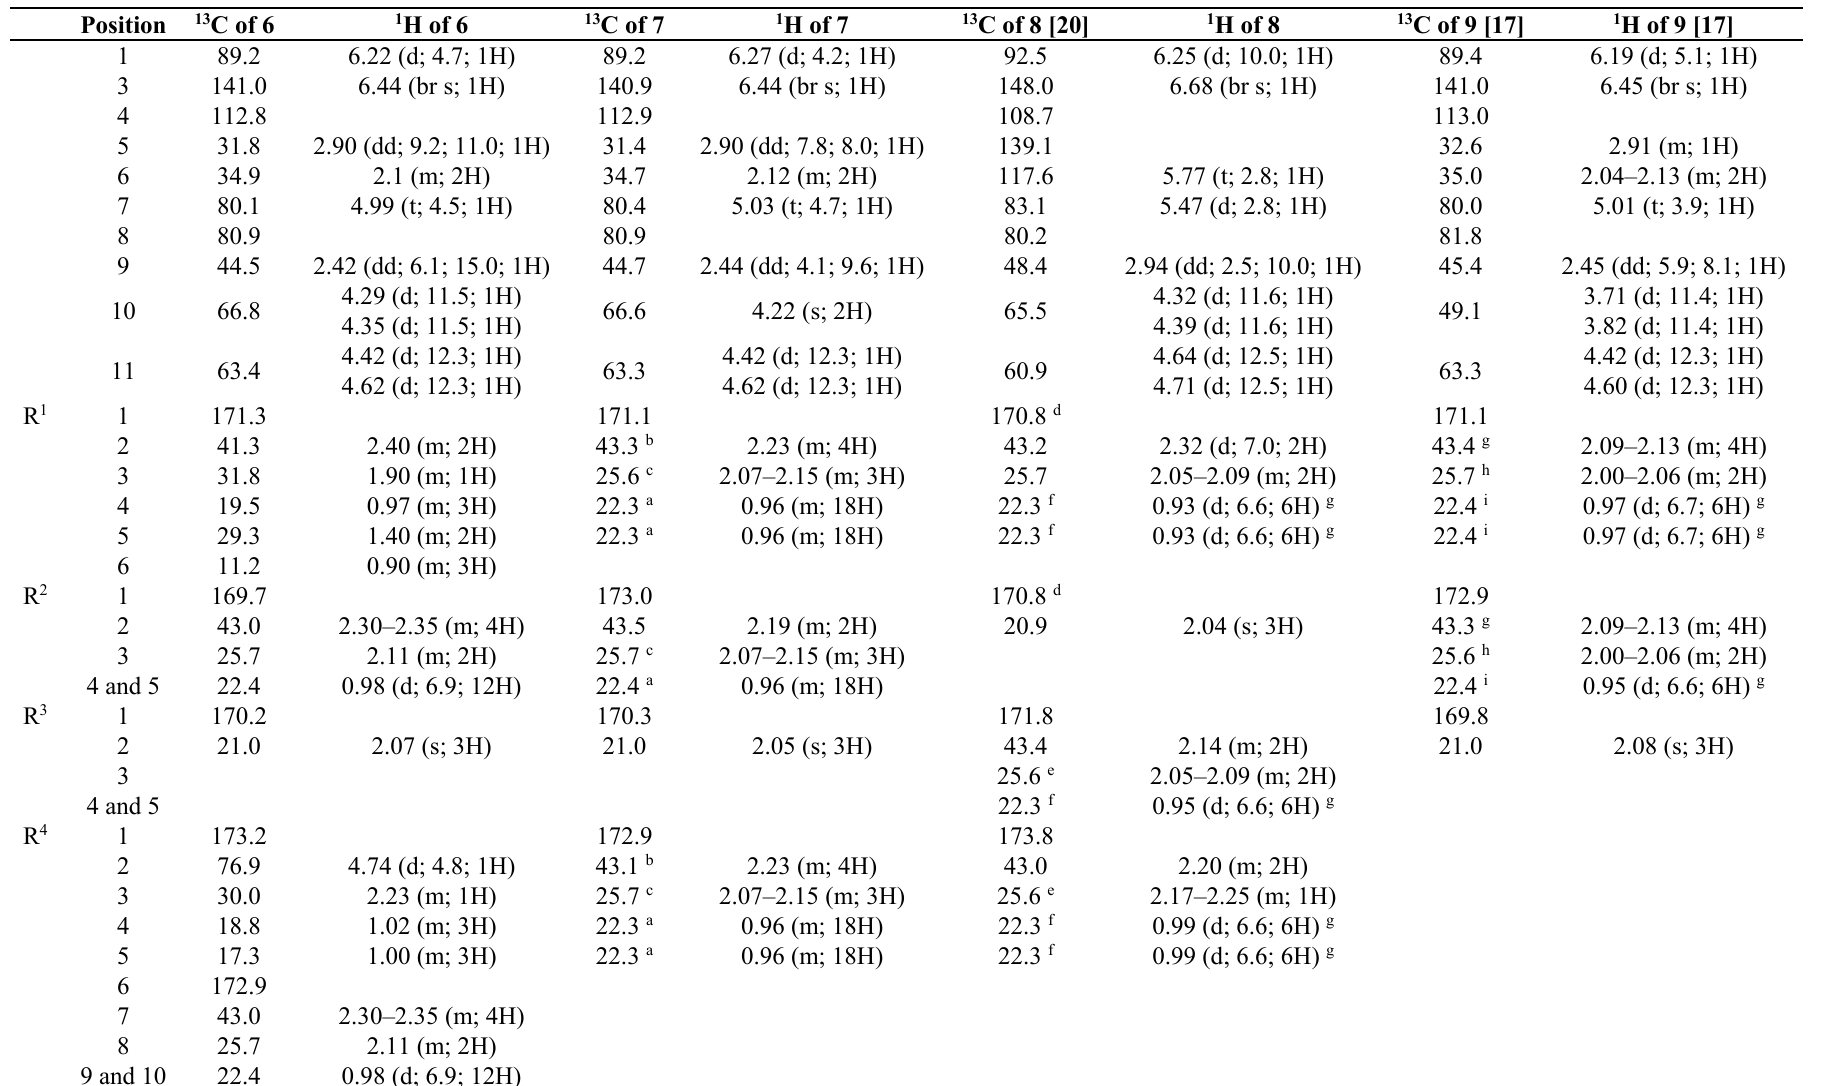
Table 1. 1 H- and 13 C-NMR data of new and known valtrates 6 – 9 in CDCl 3